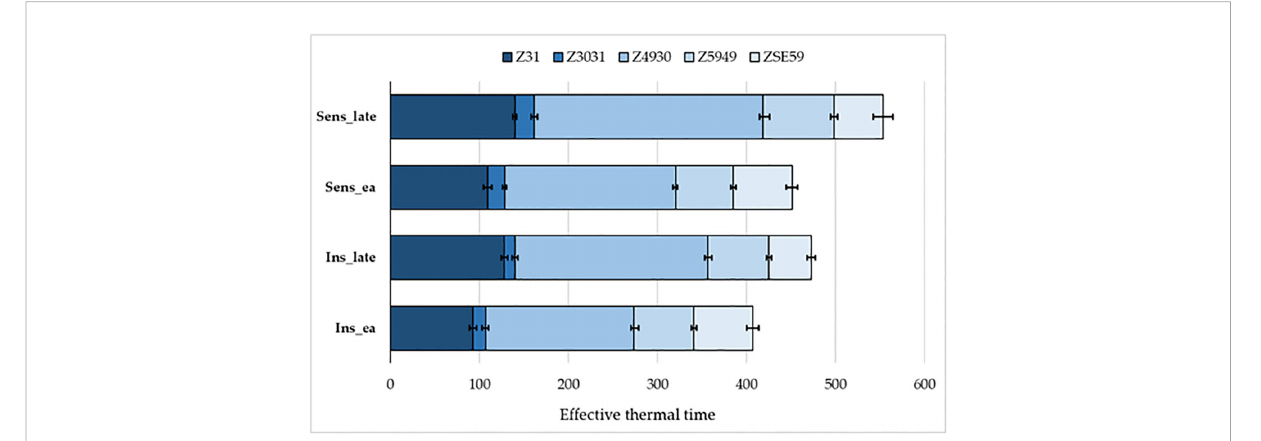
FIGURE 10 Developmental patterns of the four extreme groups combining the PPD-D1 allele phase (Insensitive – Sensitive) together with the allele phases in the most signi fi cant SNPs of plant development (highest (early) or lowest (late) number of early alleles). Error bars are standard deviations within each